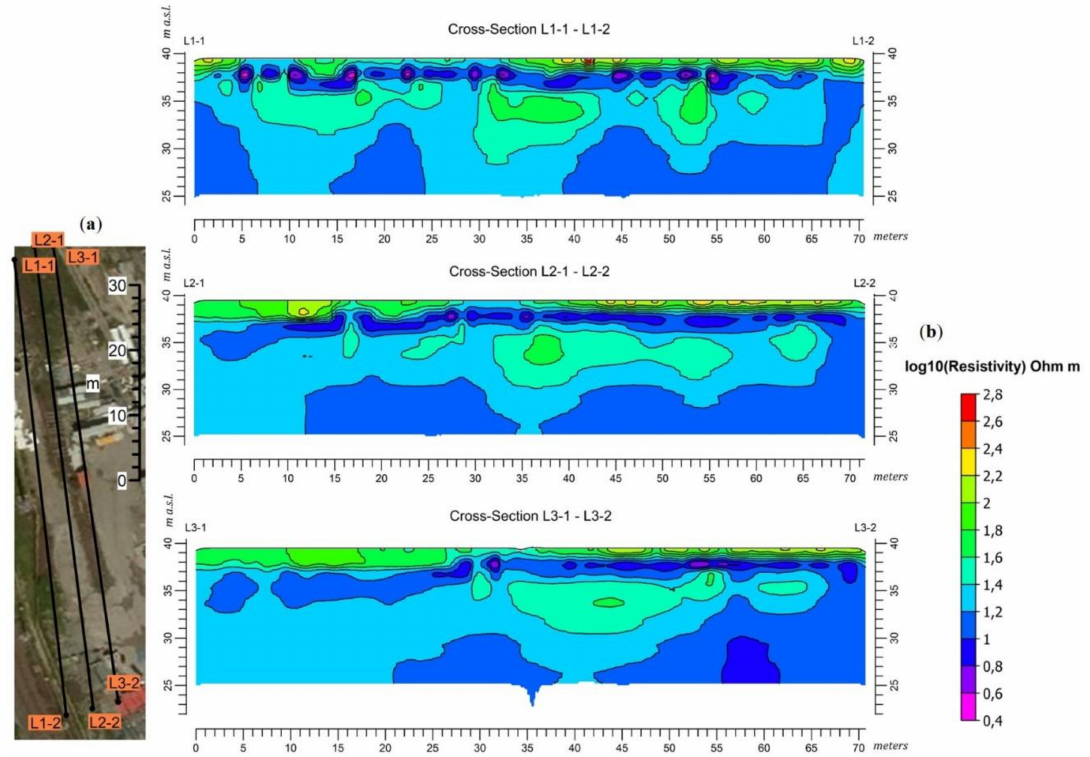
Figure 4. ( a ) Arrangement of electrodes in the soil in the pilot test area and ( b ) resulting in electrical resistivity tomography (ERT) profiles.